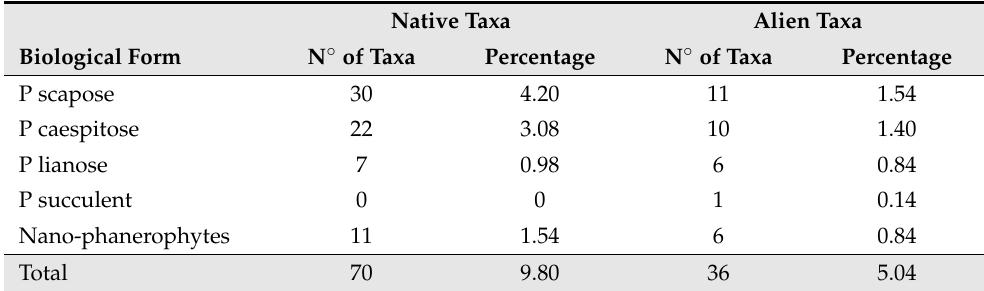
Table 2. Phanerophytes (P) occurring in the territory of Appia Antica Regional Park. Native